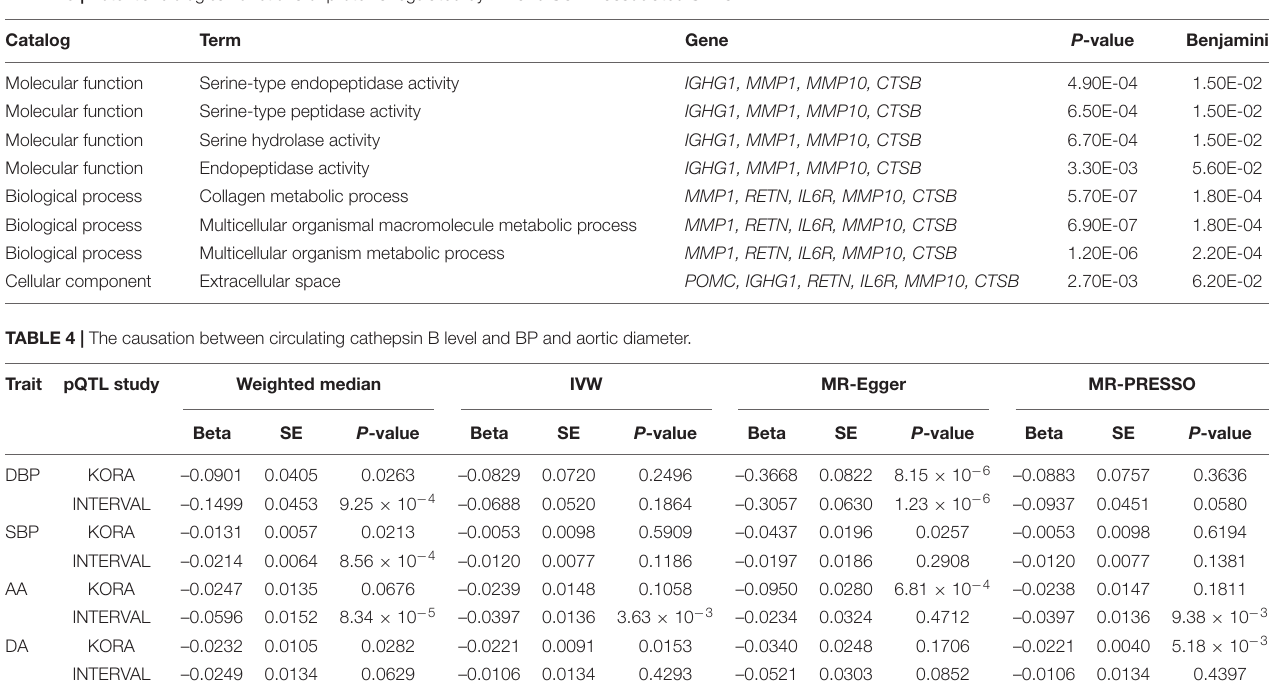
TABLE 3 | Potential biological functions of proteins regulated by BP and SCAD-associated SNPs.